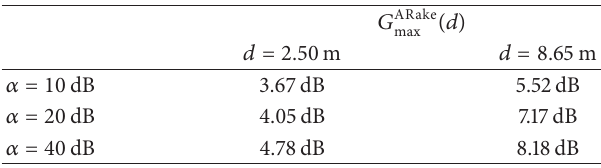
Table 3: ARake multipath diversity gain in terms of the threshold level ( 𝛼)